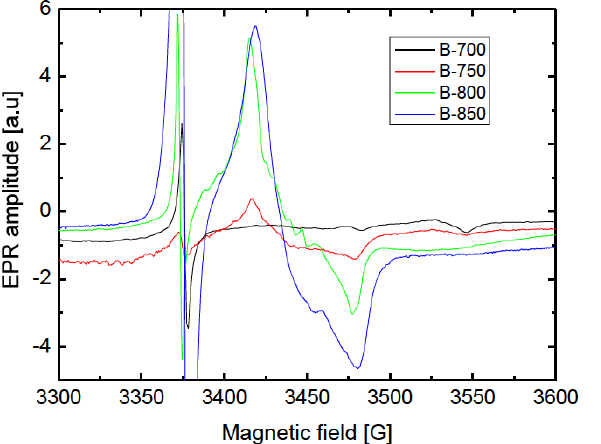
Figure 17: EPR spectra of B-700, B-750, B-800, and B-850 samples taken at T = 4 K showing the narrow N and the broad asymmetric BLT components.